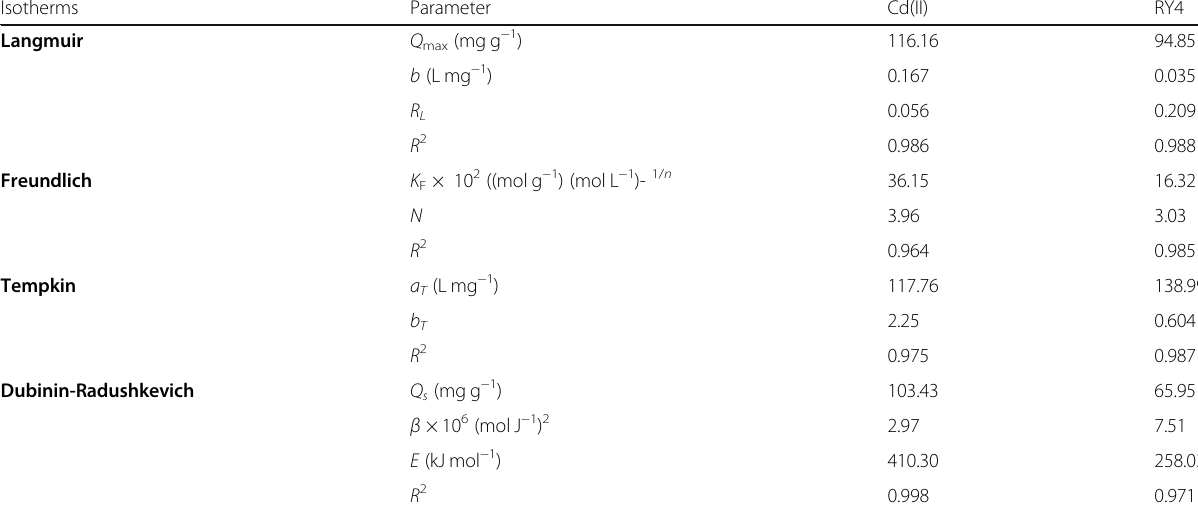
Table 2 Isotherm constants for the adsorption of Cd(II) ions and RY4 dye onto BMDA Isotherms